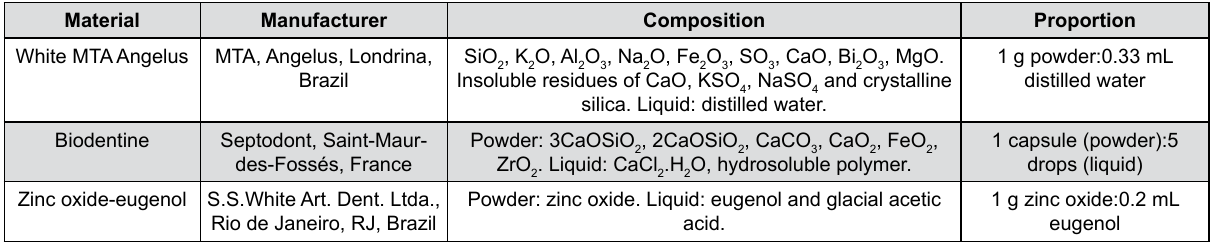
Figure 1- Root-end filling material, manufacturers, and proportions